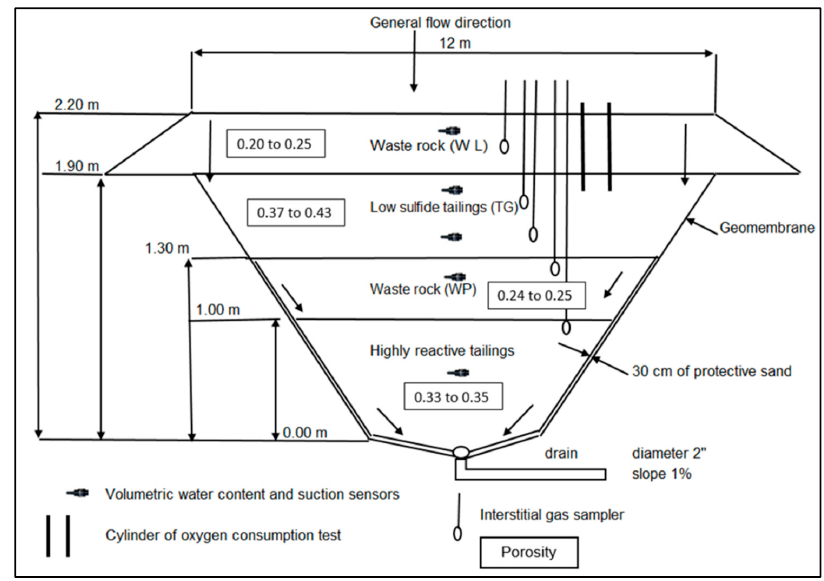
Figure 5. Schematic showing the CCBE field cell with associated instrumentation.